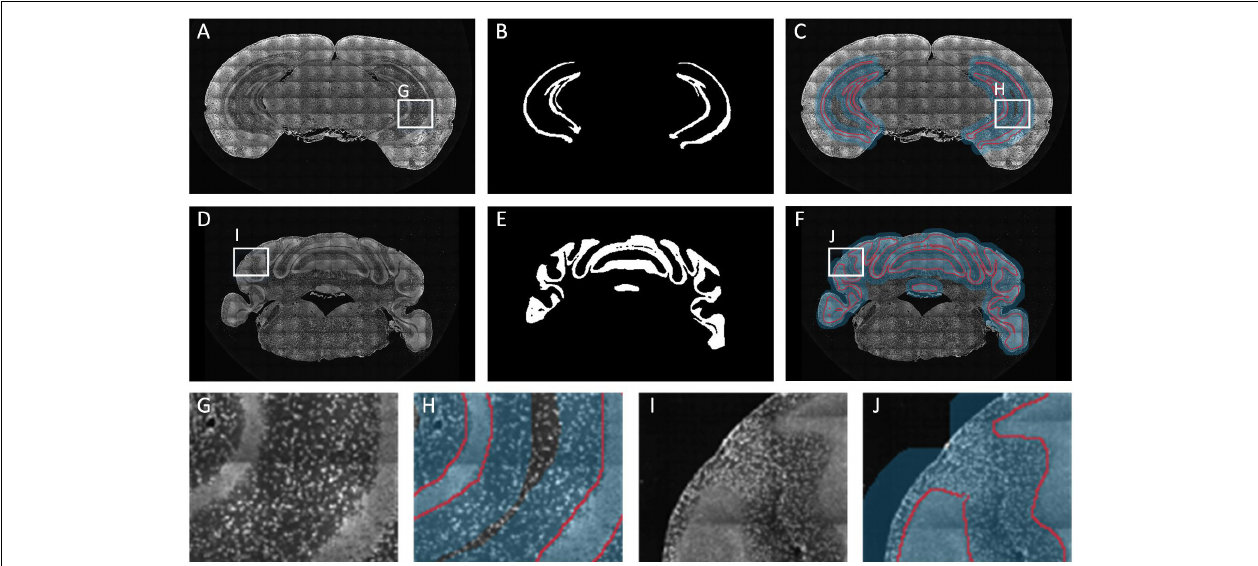
FIGURE 7 | Segmentation effects for datasets with noises. (A–C) The coronal image, the predicted binarized image, the superposition of image, the localization masks, and the segmented lines for HIP-pg. (D–F) The same as A-C for CBX-gl. (G–J) Enlarged views of the areas in white boxes in A , C , D , and F .